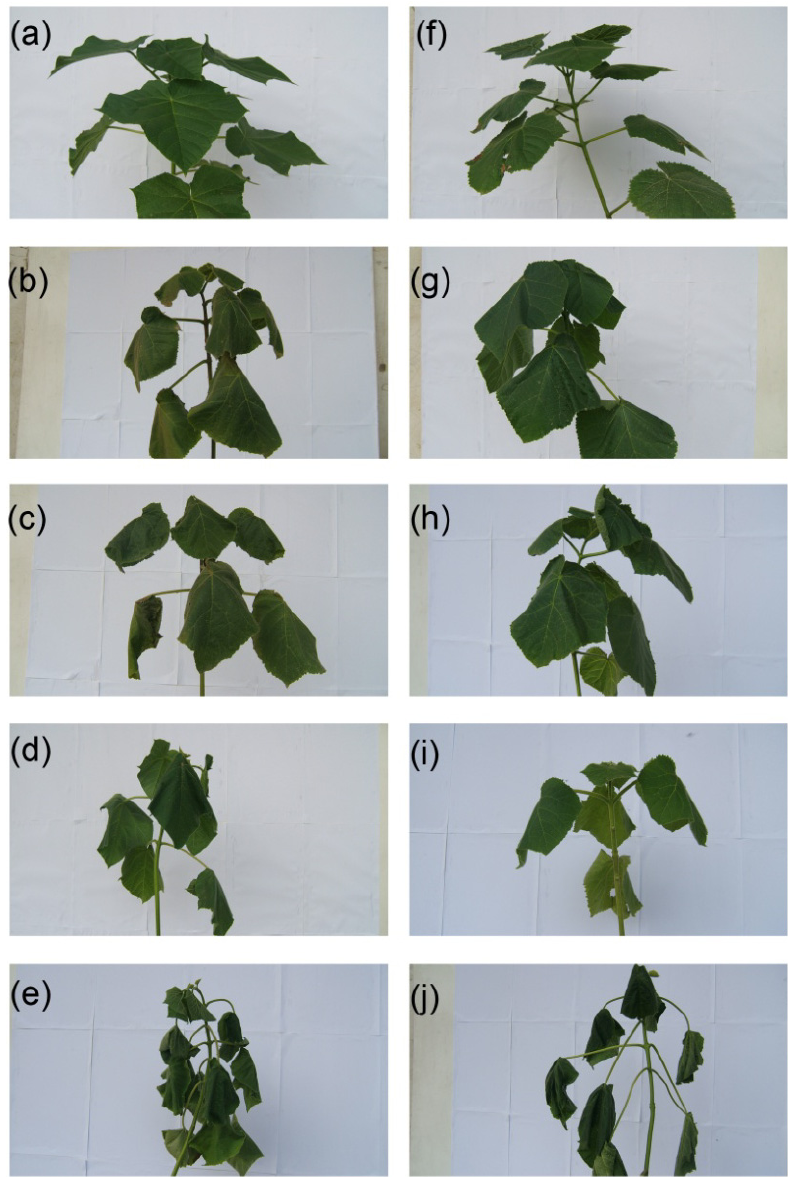
Figure 1. Physiological features of diploids and tetraploids in response to drought. PA2 represents diploid P. australis , PA4 represents autotetraploid P. australis . ( a ) PA2, well-watered diploid, 75% relative soil water content; ( b ) PA2T-1, three-day drought treated diploid, 25% relative soil water content; ( c ) PA2T-2, six-day drought treated diploid, 25% relative soil water content; ( d ) PA2T-3, nine-day drought treated diploid, 25% relative soil water content; ( e ) PA2T, 12-day drought treated diploid, 25% relative soil water content; ( f ) PA4, well-watered tetraploid, 75% relative soil water